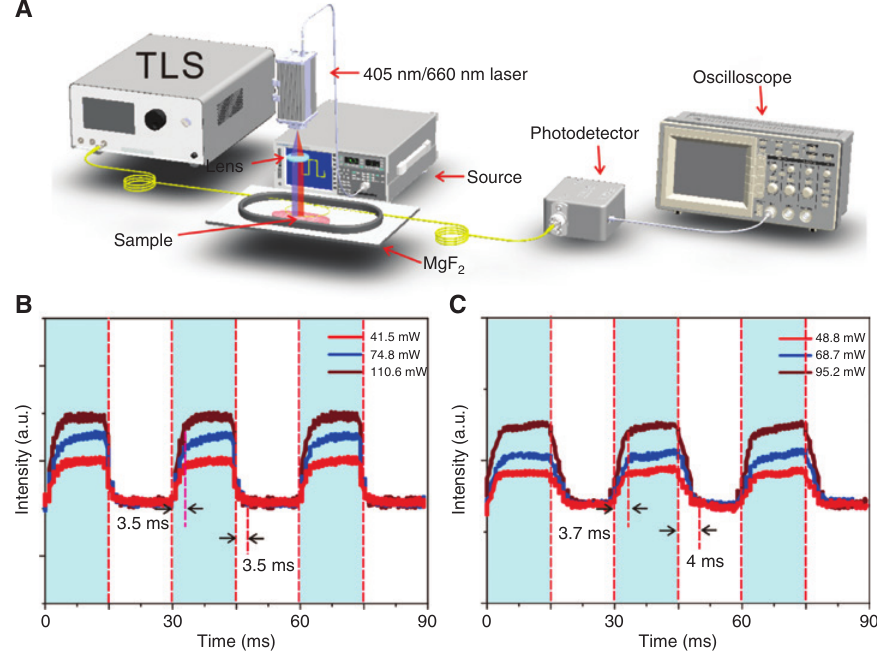
Figure 6: Response time measurement for the device. (A) Experimental setup for response time measuring under 405-/660-nm pump light. Response time under (B) 405-nm light with power of 41.5, 74.8, and 110.6 mW and (C) 660-nm light 48.8, 68.7, and 95.2